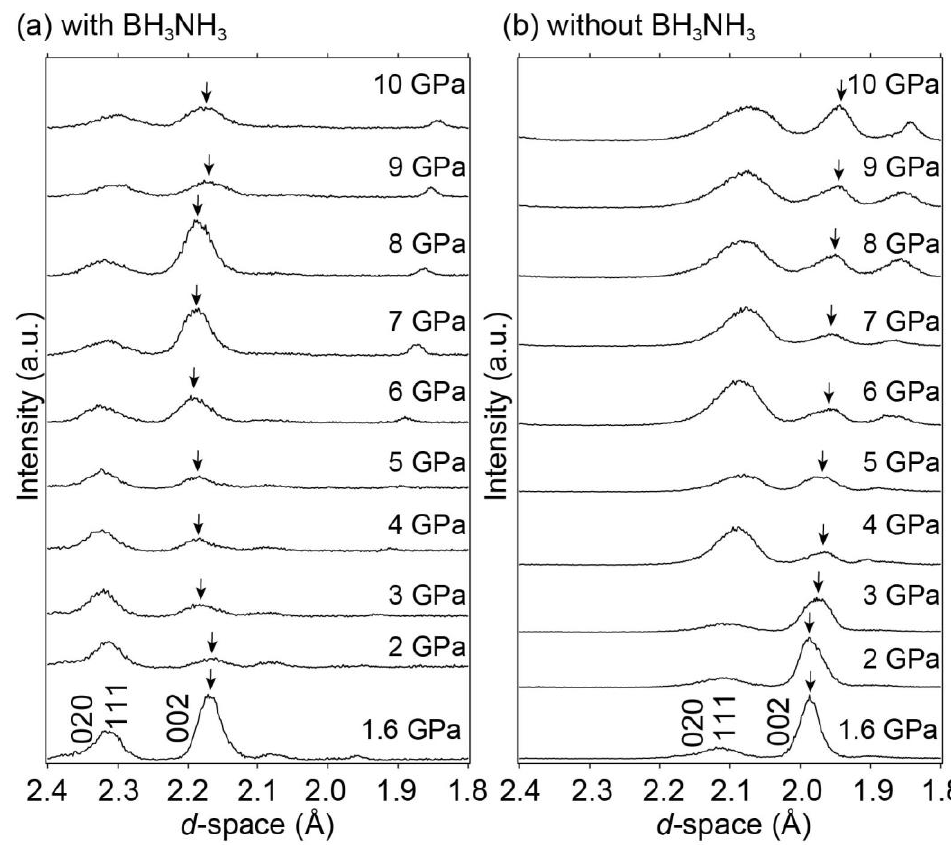
Figure 4. Synchrotron radiation X-ray diffraction patterns of LaNi 5 ( a ) with and ( b ) without the internal hydrogen source BH 3 NH 3 at room temperature and 1.6–10 GPa focusing on Bragg peaks of the (020), (111), and (002) reflections. Arrows indicate the Bragg peak of (002) at each pressure.